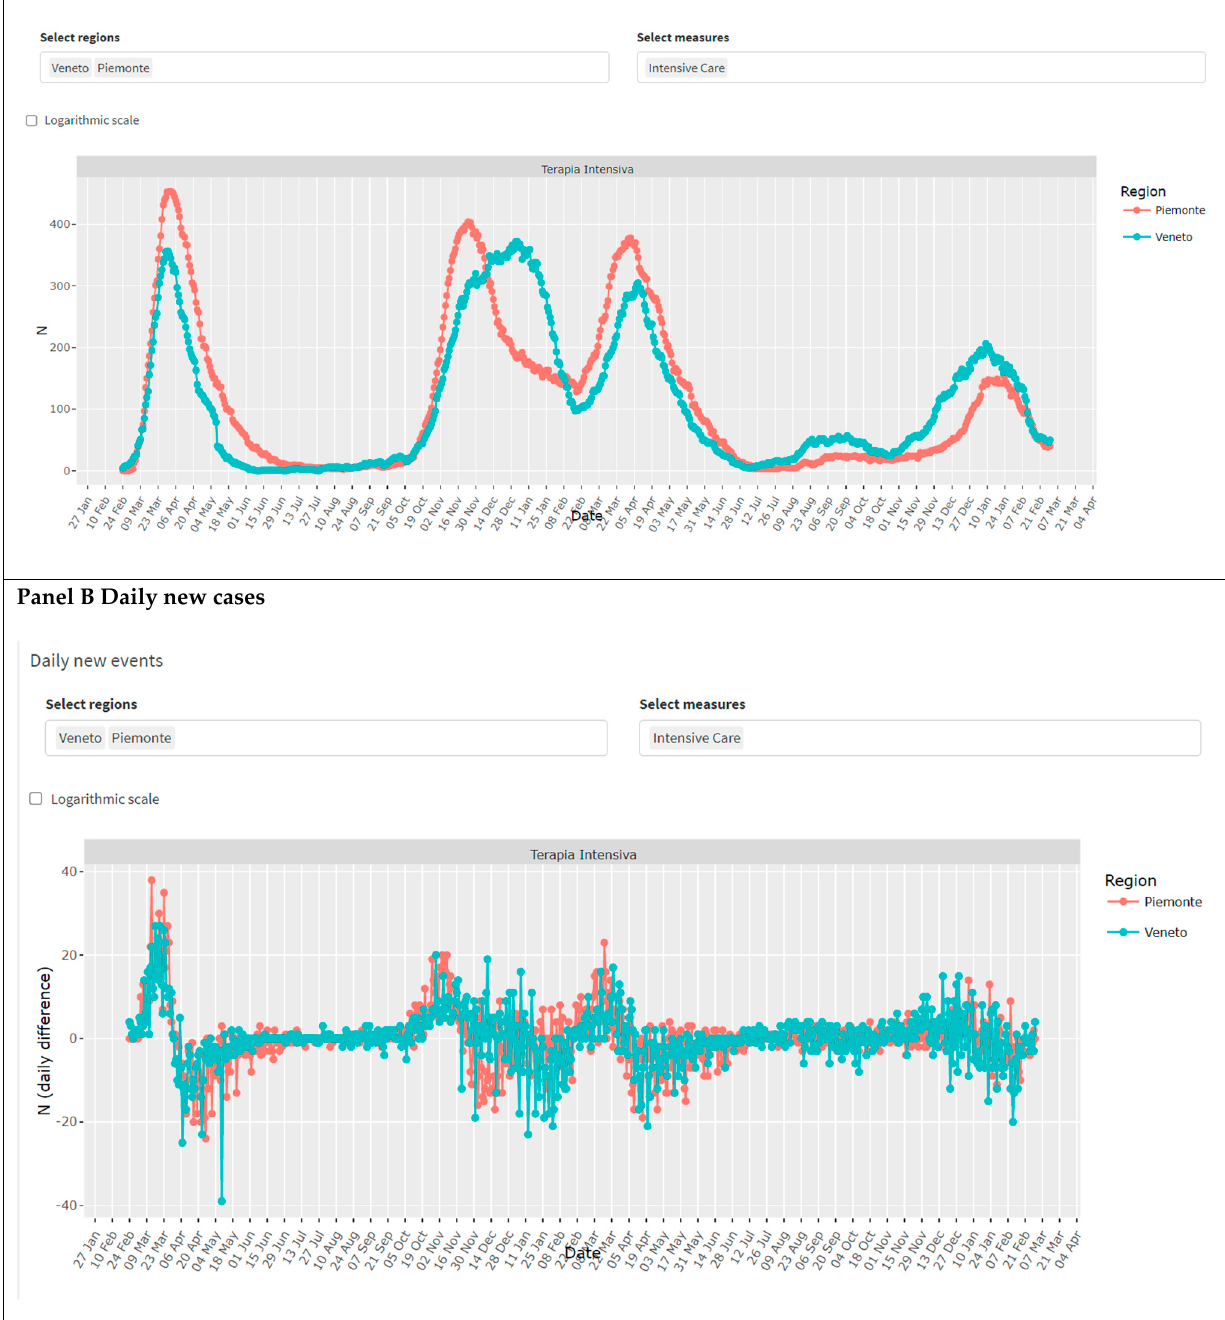
Figure 4. Epidemic section of the COVID-19 pandemic application (web page screenshot). The first two sections from the top report the total number of ICU cases (Panel ( A )) and the daily ICU admissions (Panel ( B )) in the Veneto and Piemonte region. Region and indicator can be chosen by the user.